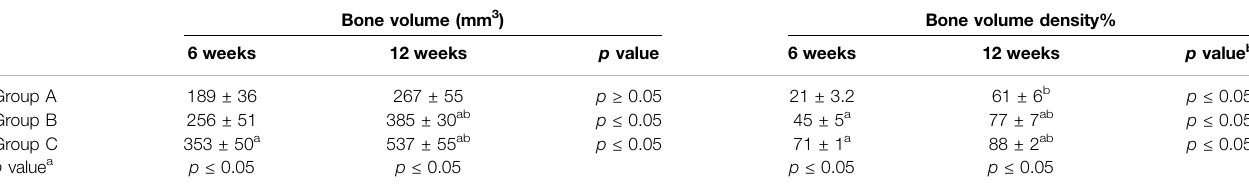
TABLE 1 | Comparison of means bone volume and bone volume density between groups (group A (control), group B (chitosan gel), group C (OPG-chitosan gel)).